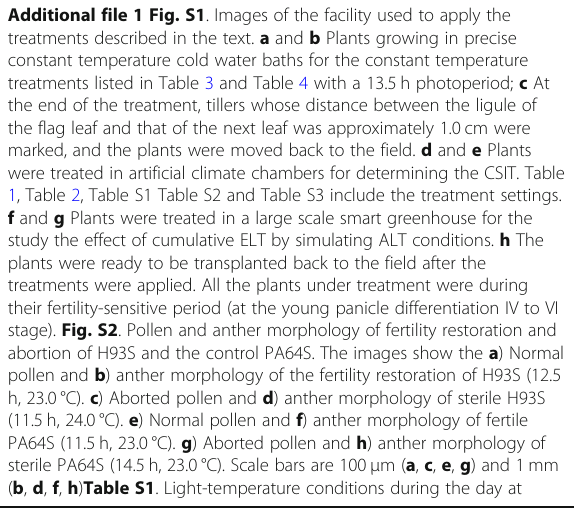
PFP: Pollen fertility percentage; SSP: Self-seed setting percentage; t 1 : Treatment time at 26.0°C; t 2 : Treatment time at the temperature of T c -T Δ